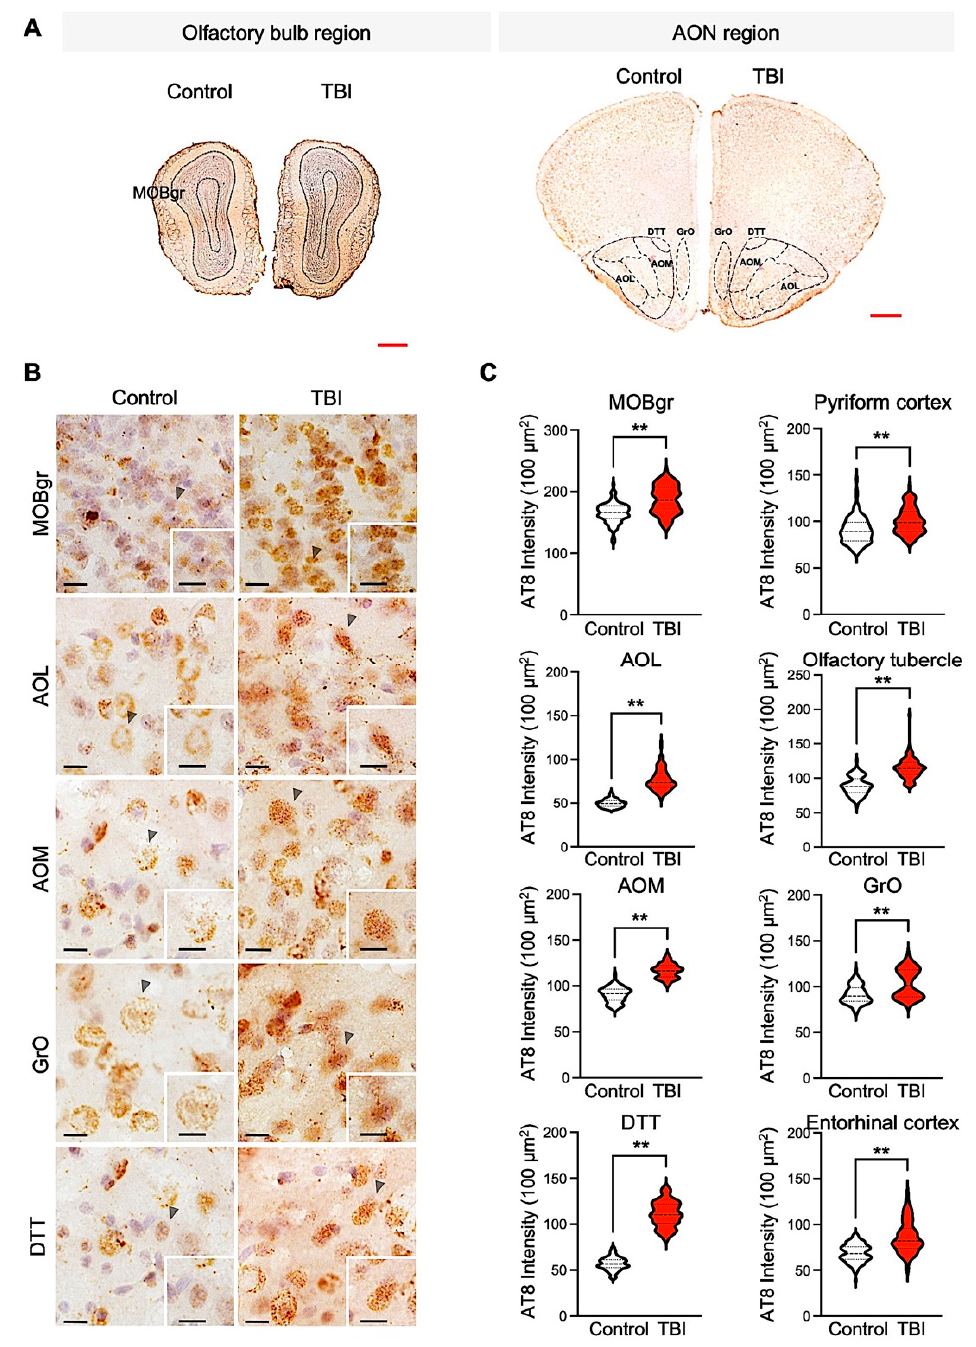
Figure 3. Olfactory-bulb-associated areas exhibit increased phosphorylated tau (p-Tau) level in TBI mice. ( A ) Representative hemisphere images of the olfactory bulb region ( left panel ) and AON region ( right panel ) in control and TBI mice. Scale bars (red): 500 µ m. ( B ) TBI increased the immunoreactivity of p-Tau (Ser202/Thr205) in the olfactory bulb region. Scale bars (black): 10 µ m. ( C ) Densitometry analysis showed a significant increase of p-Tau level in repetitive TBI mice compared to control mice (control, N = 5; TBI, N = 5). Error bars indicate SEM; **, significantly different from control at p < 0.01.